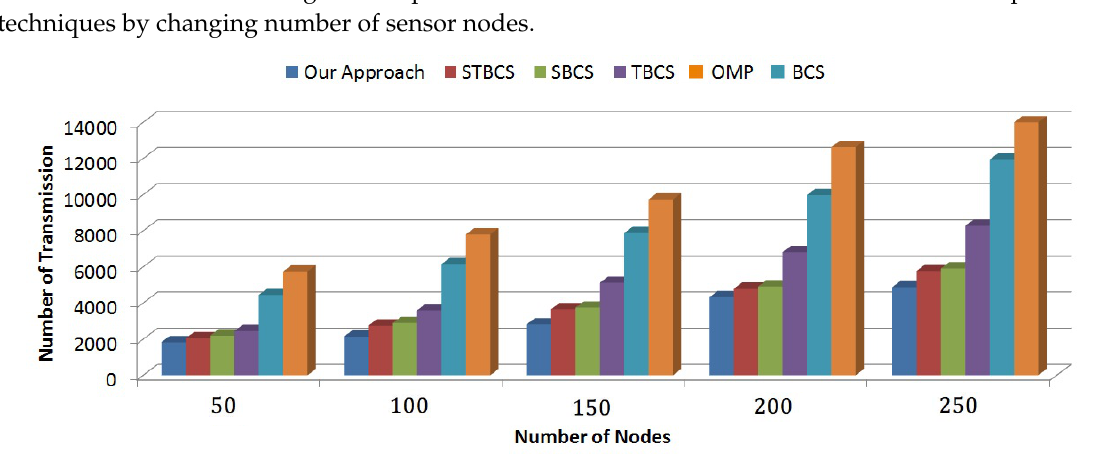
Figure 14. Number of data transmission versus number of sensor